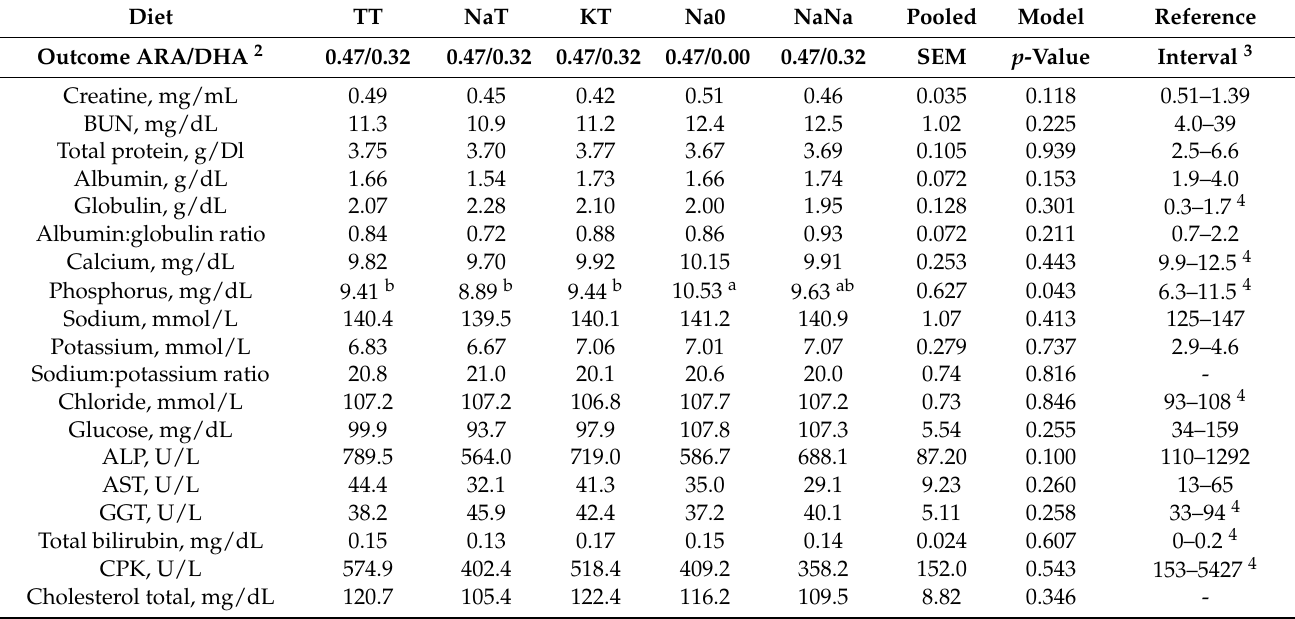
Table 3. Serum chemistry analytes of pigs receiving experimental milk replacers with different sources of ARA 1